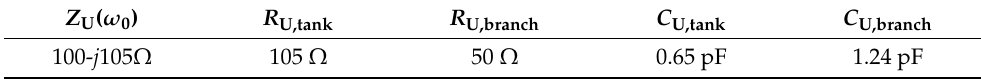
Figure 7. Using Smith Chart validates the input impedance of R-CMNF and checks that it works as an inductive load. Table 3. Derivation component value of the unified